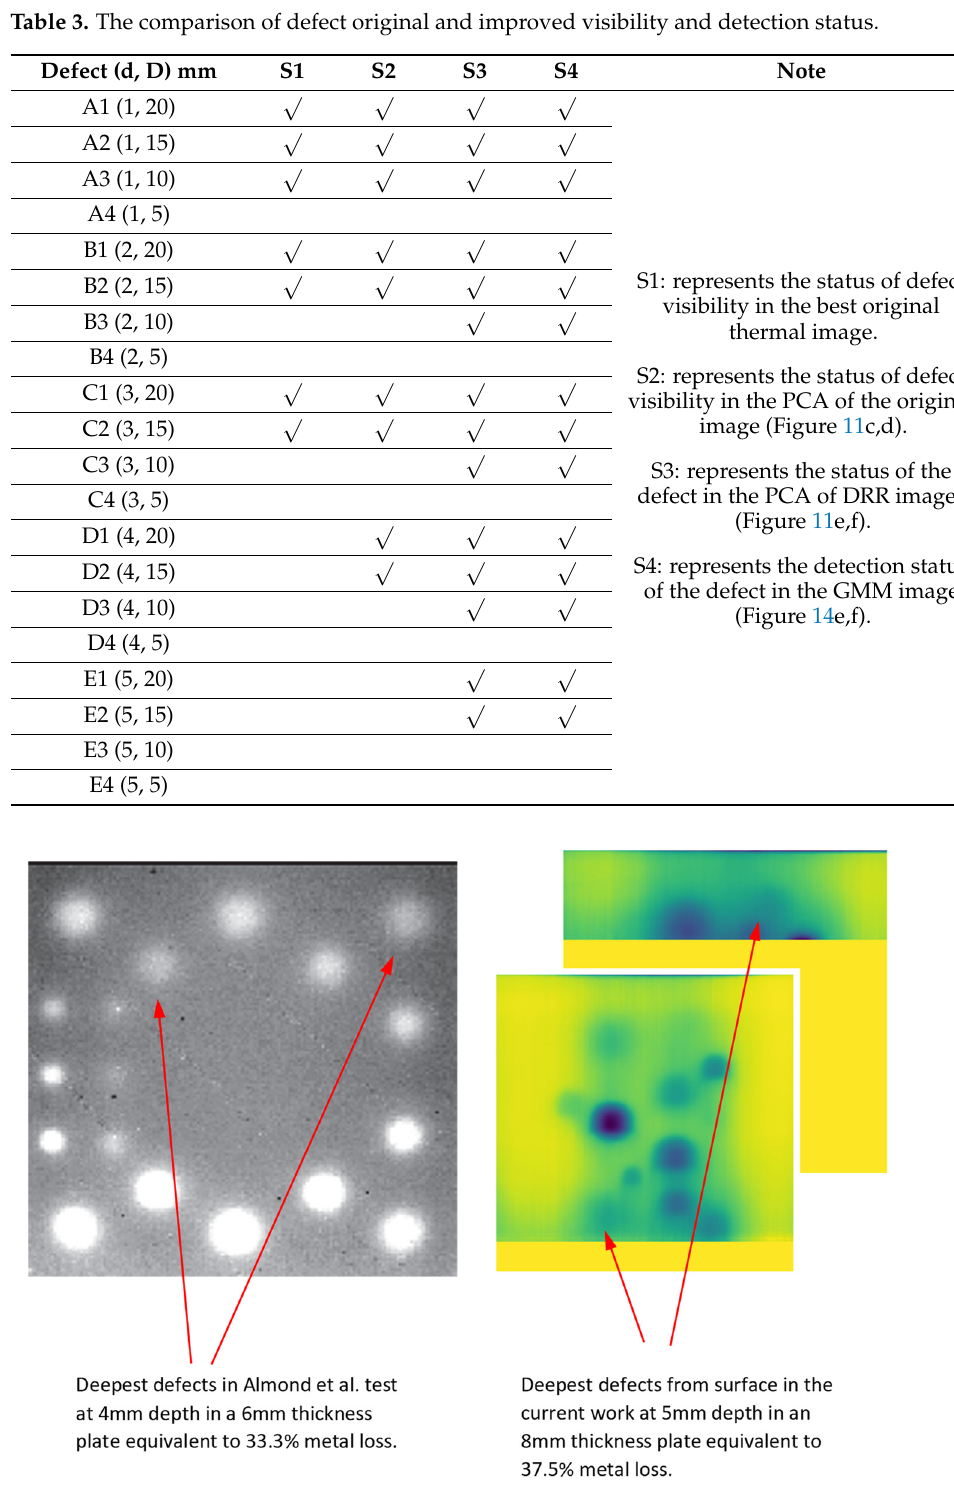
Figure 15. A comparison of unprocessed (raw) images of defects in mild steel using long heating pulse versus cooling excitation. Left represents a 6 mm thickness mild-steel plate subjected to 5 s heat pulse [37]. Right represents the results of current work comprising an 8 mm thickness mild-steel subjected to cold burst and registered immediately after being revealed to the camera. Reproduced with permission from Almond et al., Long pulse excitation thermographic non-destructive evaluation; published by NDT&E International, Elsevier, 2017. Licence number 5095160469715.